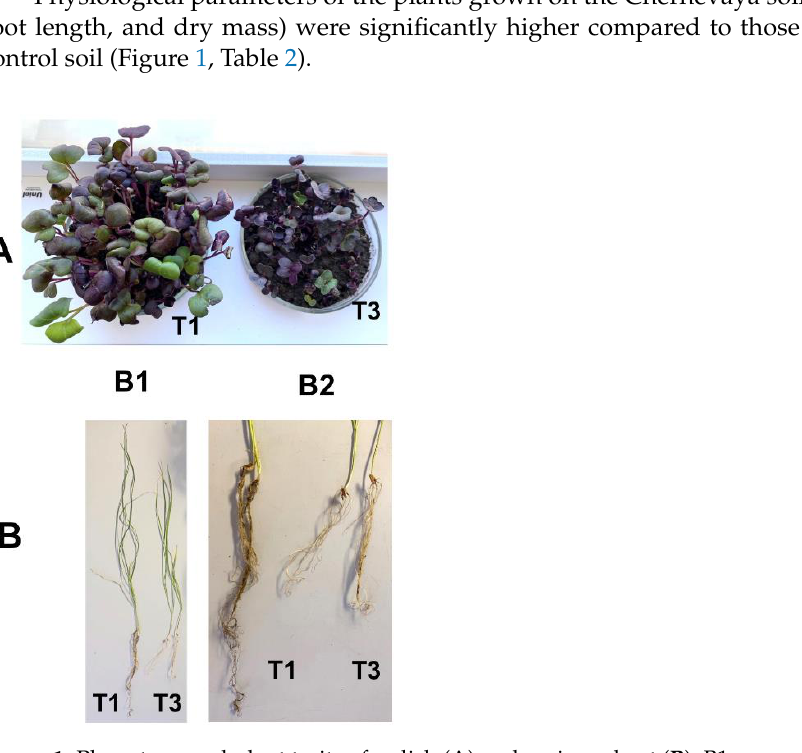
Figure 1. Phenotype and plant traits of radish ( A ) and spring wheat ( B ). B1: general view of wheat plants used in the experiment; B2: details of their root system. Plants were grown in the pot experiment with Chernevaya soil (T1) and the control soil (T3) samples. Table 2. Measurements of the physiological parameters of radish and wheat plants grown in pots with control and Chernevaya taiga